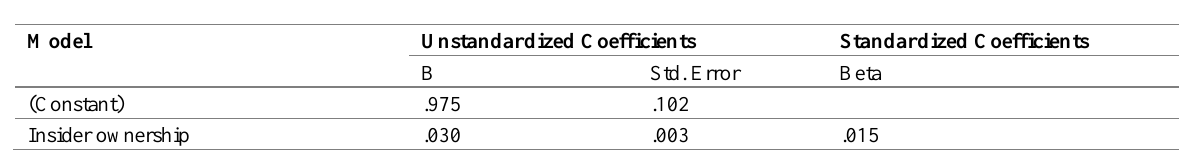
Table 4: Linear regression analysis result